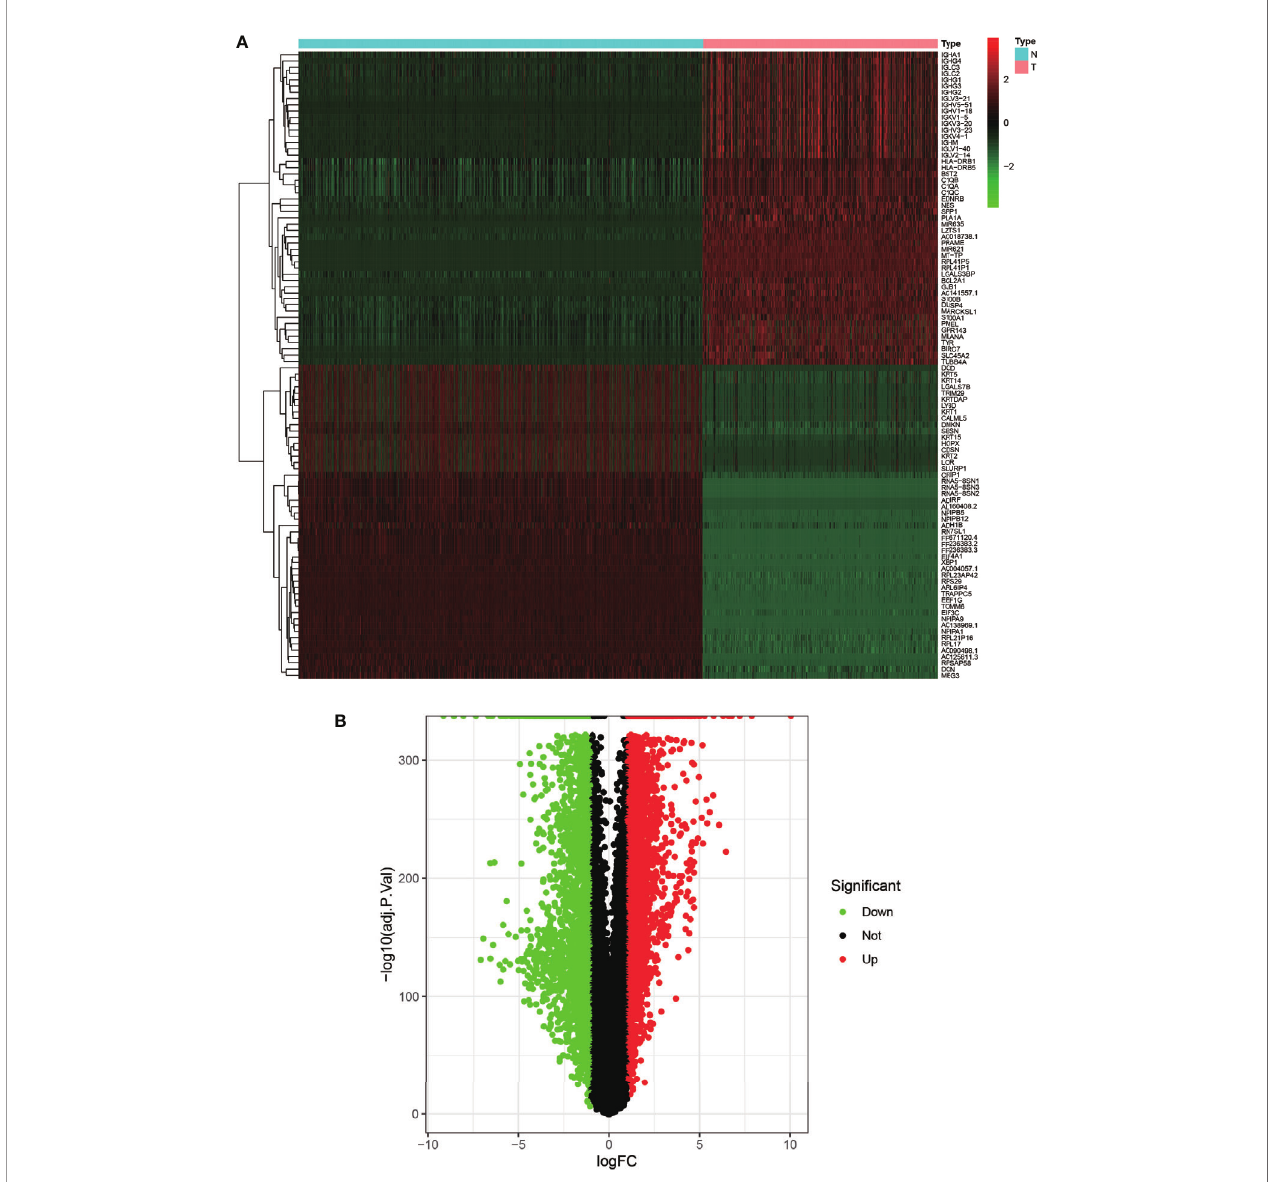
FIGURE 1 | Heat map and volcano map of DEGs from the UCSC Xena database. (A) Heat map of the top 50 upregulated and top 50 down-regulated DEGs obtained from the identi fi cation. The red part indicates upregulated genes, and the green part indicates down-regulated genes. (B) Volcano plot with cut off value set to |logFC|>1,P-value<0.05. Red dots indicate upregulated genes, green dots indicate down-regulated genes, and black represents non-signi fi cant